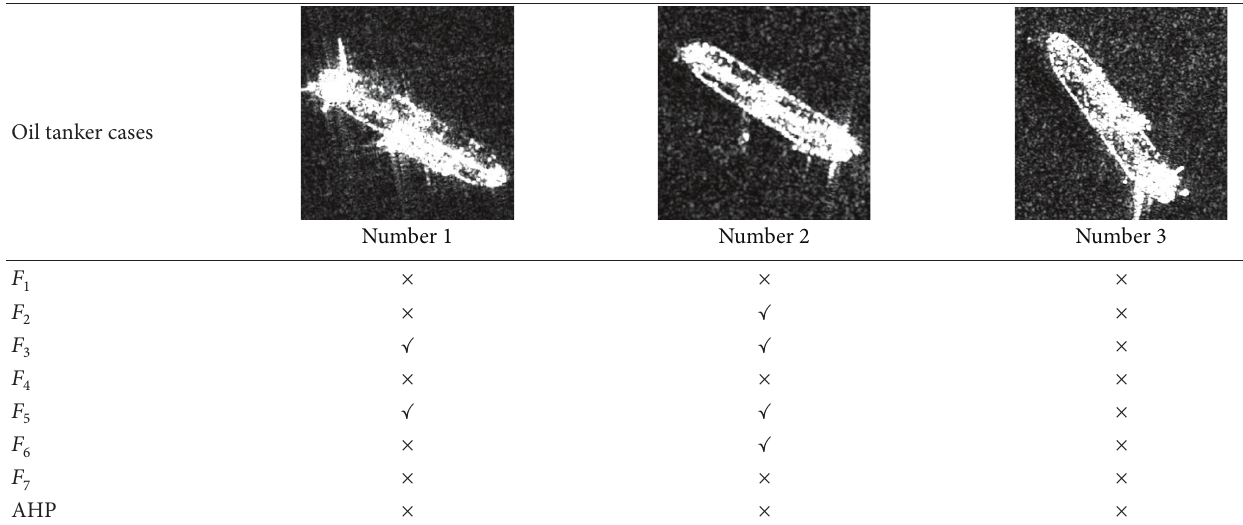
Table 4: Wrong classification cases for oil